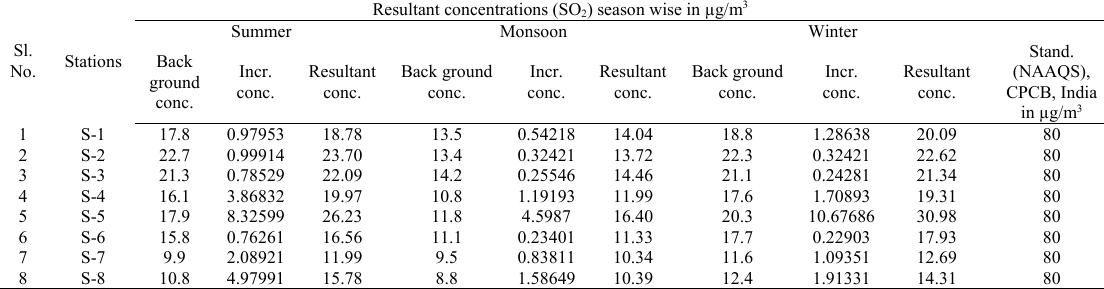
Table 4: Resultant concentrations respective to station and season wise for SO 2